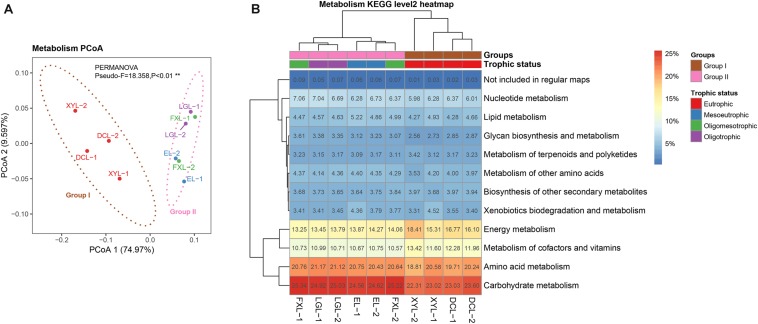
Functional structure of planktonic microbial communities in lakes with different trophic status. (A) PCoA based on selected KOs involved in the metabolism pathway with 90% confidence ellipses. (B) Heatmap representing the functional clustering of the predicted CDS from the metagenomic data based on the KEGG categories of metabolism level 2. Hierarchical clustering (UPGMA) based on Bray–Curtis dissimilarity matrices.